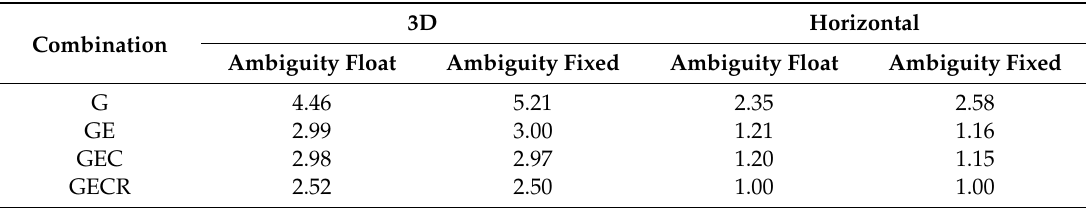
Table 2. Average root-mean-square (RMS) errors of the 3D and horizontal component of di ff erent combinations. The unit is